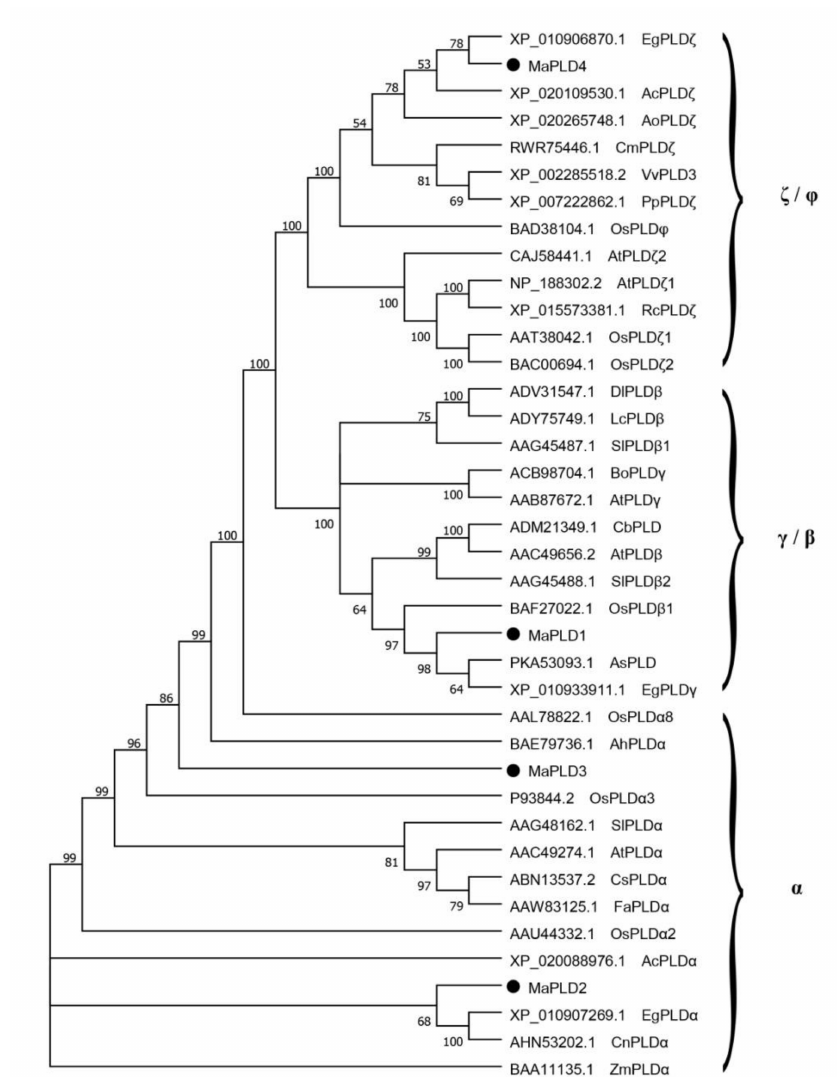
Figure 3. Phylogenetic analysis of PLD genes in banana (marked with black solid circles) with other PLD s from plants. The NJ tree was constructed by MEGA 7.0. All sequences were labeled with names and GenBank accession